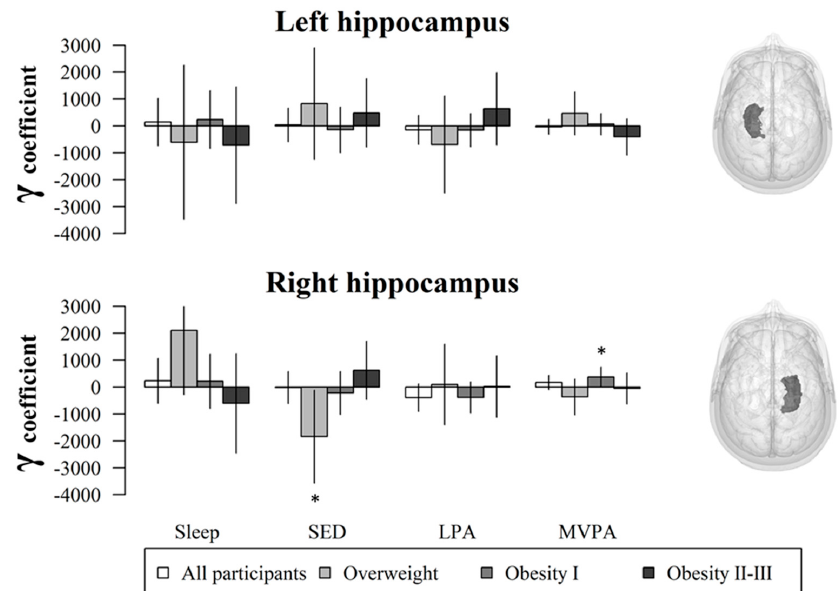
Figure 2. Compositional models γ coefficients and 95% confidence intervals (i.e., error bars) for the association of SED, LPA, and MVPA with GMV in the hippocampus adjusted for sex, peak height velocity, parental university level, and total brain volume. Each bar represents the association of the pertinent behavior (e.g., SED) relative to the remaining behaviors (e.g., LPA, MVPA, and sleep) with GMV in the hippocampus. *Indicates statistical significance (p < 0.05). SED: sedentary time; LPA: light physical activity; MVPA: moderate-to-vigorous physical activity.